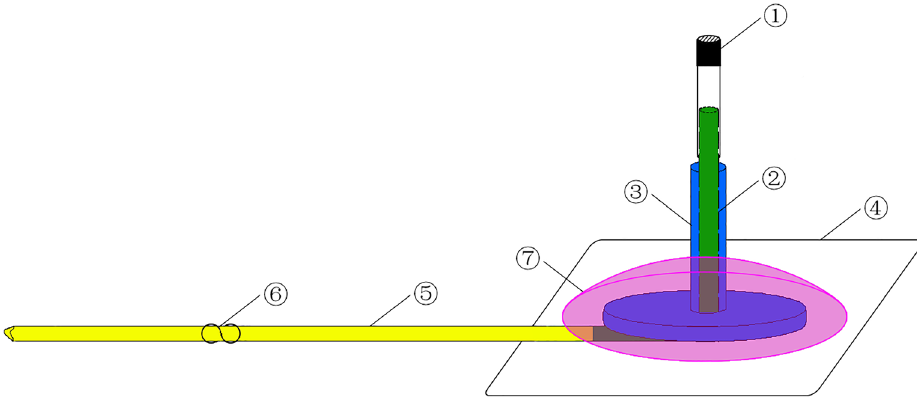
Figure 1. The schematic map of optimized jugular vein catheter. ① a PE tube cap; ② an L-shaped stainless steel tube; ③ an M4-style threaded base with inner hole; ④ a Nylon mesh; ⑤ a silicone tube; ⑥ an S-shaped positioning nail; ⑦ Hot melt